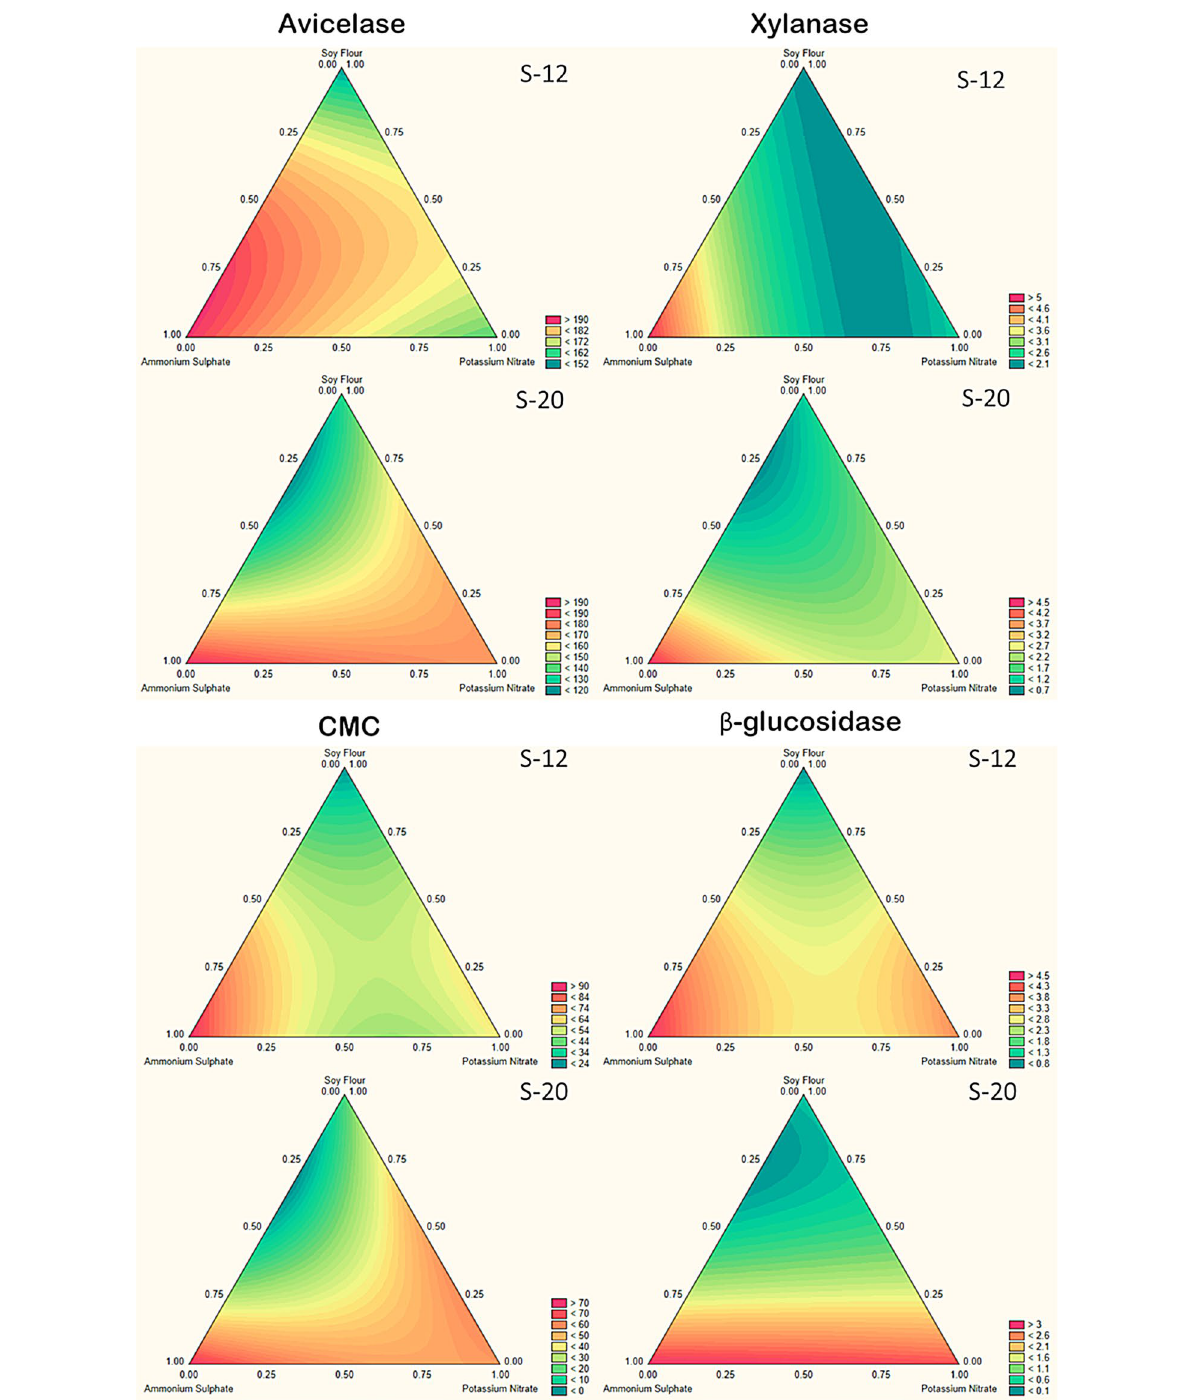
Fig. 3 Surface contour plot of avicelase, xylanase, CMC, and β-glucosidase activities under different feed source treatments using the solid (S) inoculum at time periods of 12 and 20